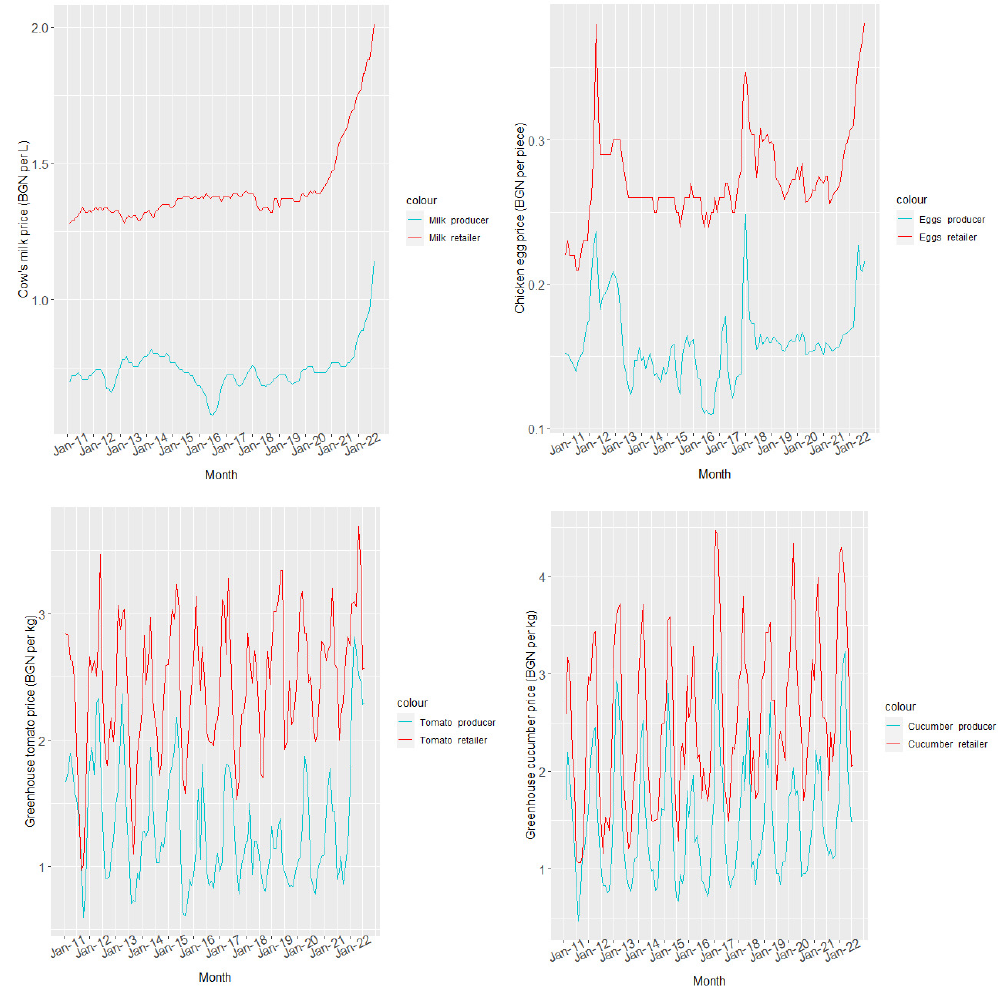
Figure 2. Monthly prices of cow’s milk, chicken eggs, greenhouse tomatoes and greenhouse cucum- bers from January 2011 to July